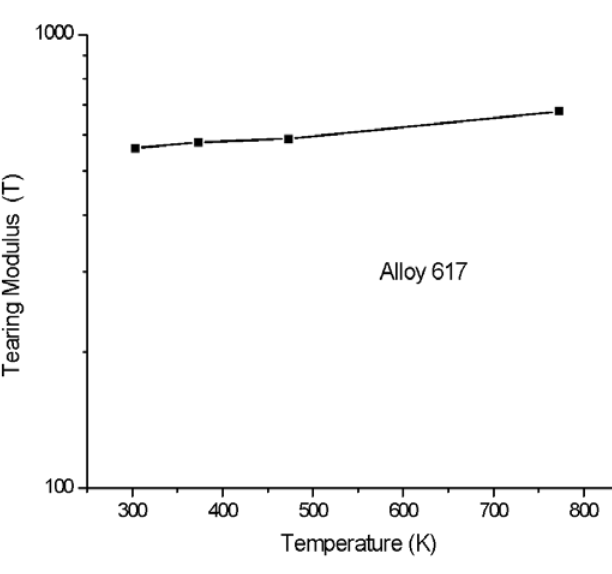
Figure 9: J-Integral vs. Δ a at Ambient Temperature